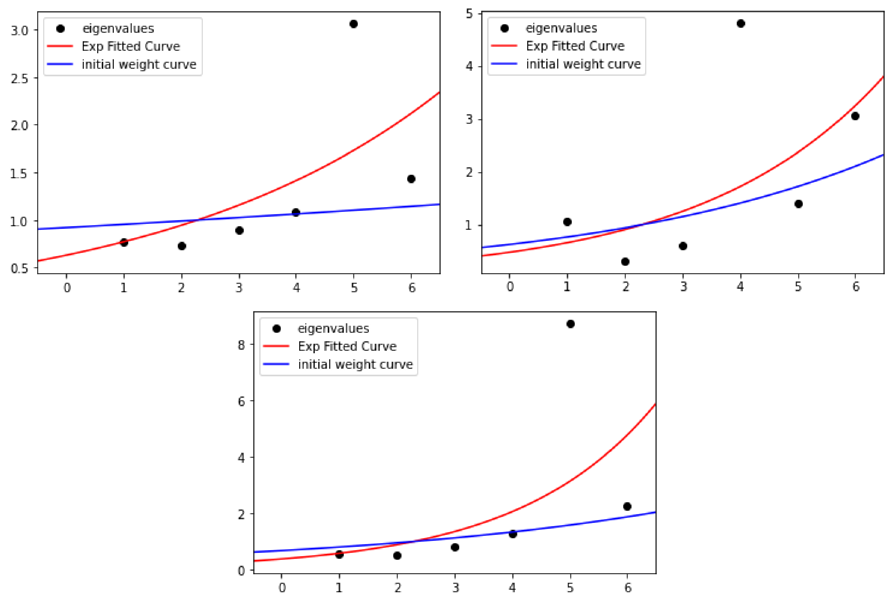
Figure 4 . Top left and right are two different solutions from L 26 ( k = 500) and L 26 ( k = 1000) , while the bottom is a solution from L ( k = 1000) . As a comparison, the top left fit loss was larger 24 than 44% the respective random losses found in section